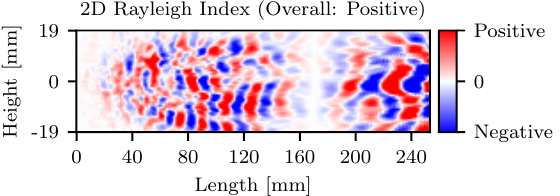
Figure 16. 2D Rayleigh Index of the chamber’s first longitudinal resonance mode based upon CH* radiation for the first interval in LP1.